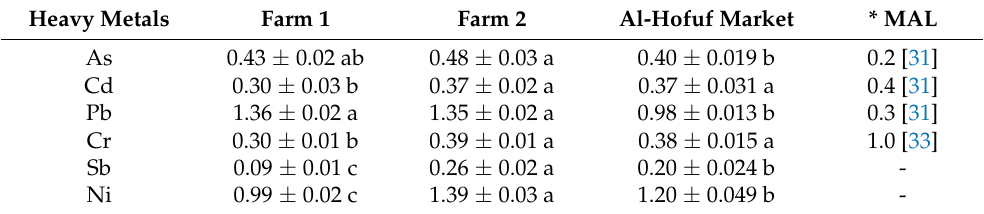
Table 2. Mean square of the effect of cooking conditions on the heavy metals of rice.